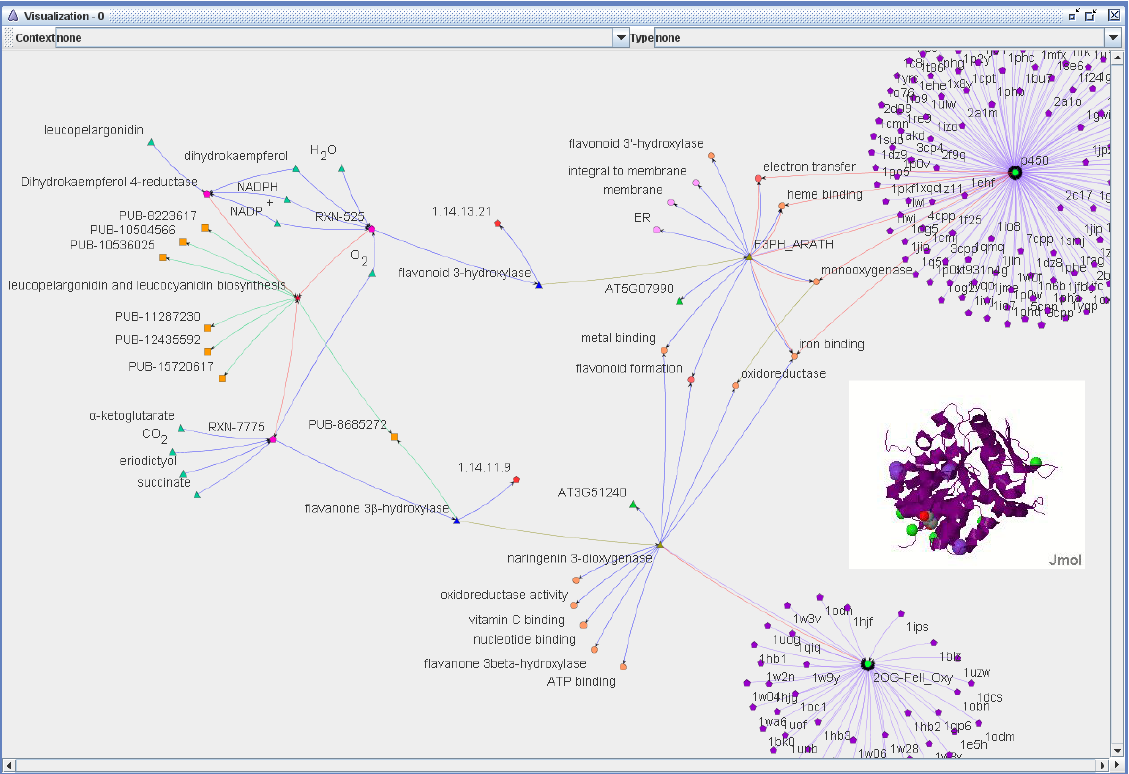
Figure 6: Resulting representation of an extract of the “leucopelargonidin and leucocyanidin biosynthesis”. An AraCyc pathway in OVTK2 with GO, PFAM and Structure